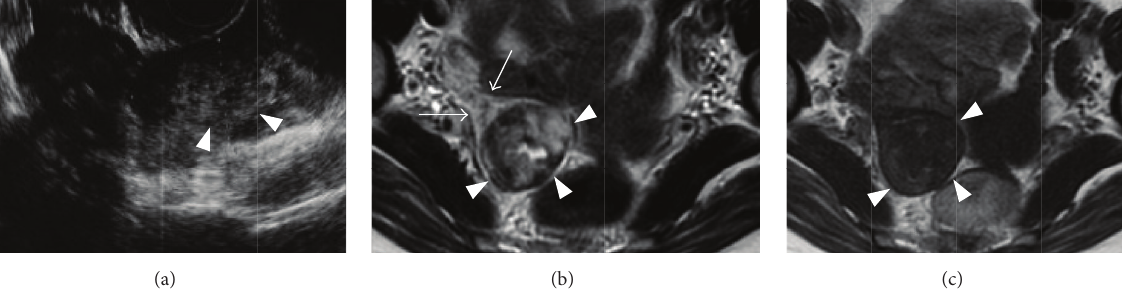
Figure 1: (a) Transvaginal ultrasonography reveals an echogenic mass (arrowhead) incarcerated to the right ovary and a normal endometrium. (b) Axial T2-weighted MR image shows a GS structure of heterogeneous high intensity (arrowhead), containing punctate foci of distinct low intensity. The GS is incarcerated to the right ovary, forming a “beak sign” (arrows). (c) Axial T1-weighted MR image showed GS structure (arrowhead) containing punctate foci of high intensity.